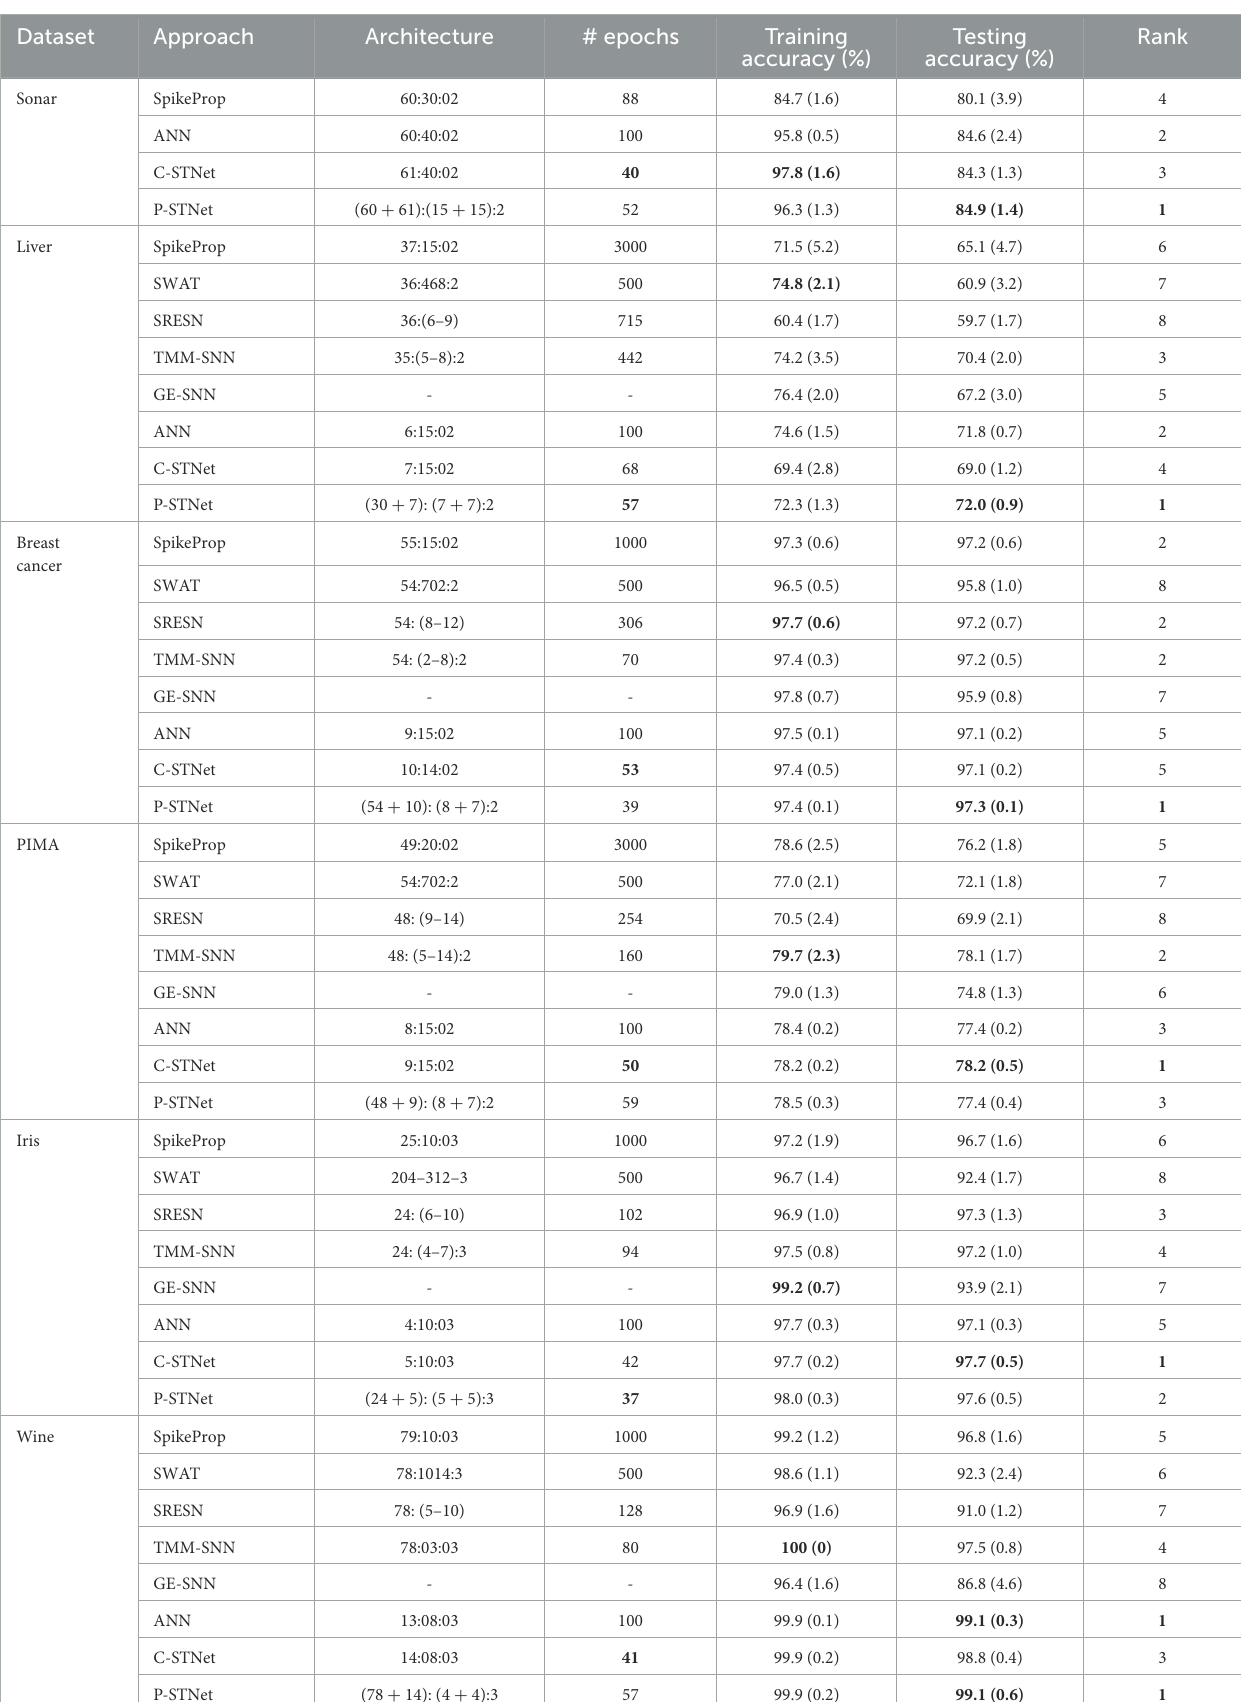
TABLE 3 Experimental results of eight approaches on the six little